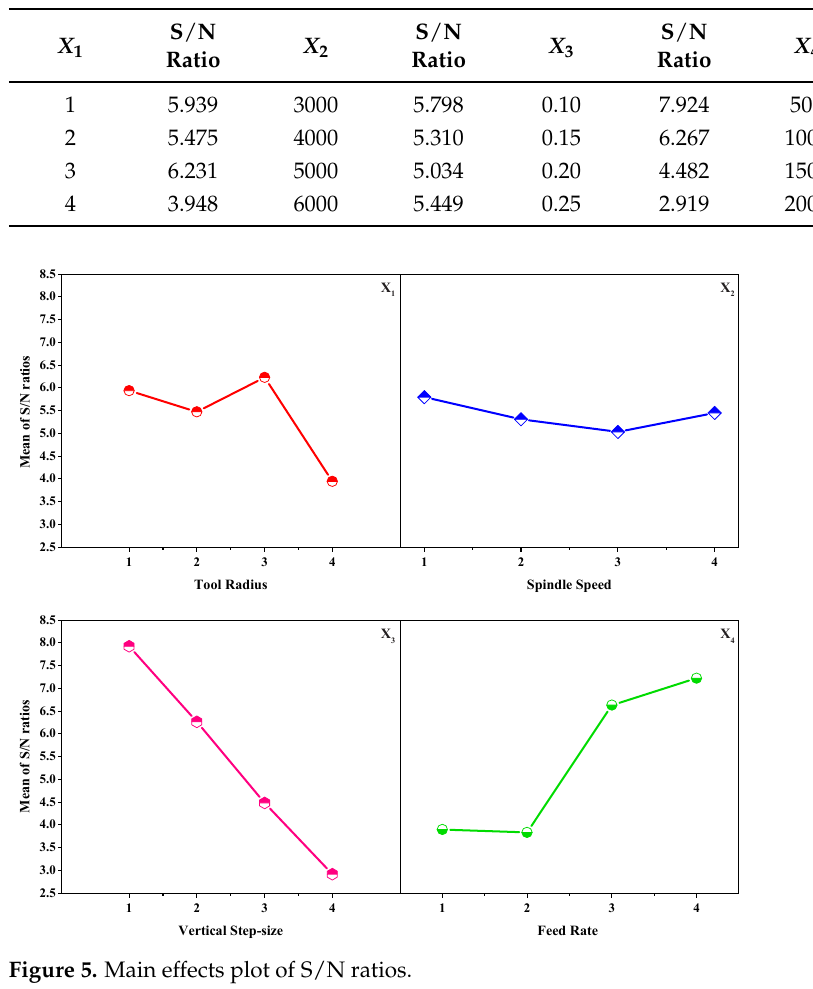
Table 4. Main effects of forming parameters on mean S/N ratios.